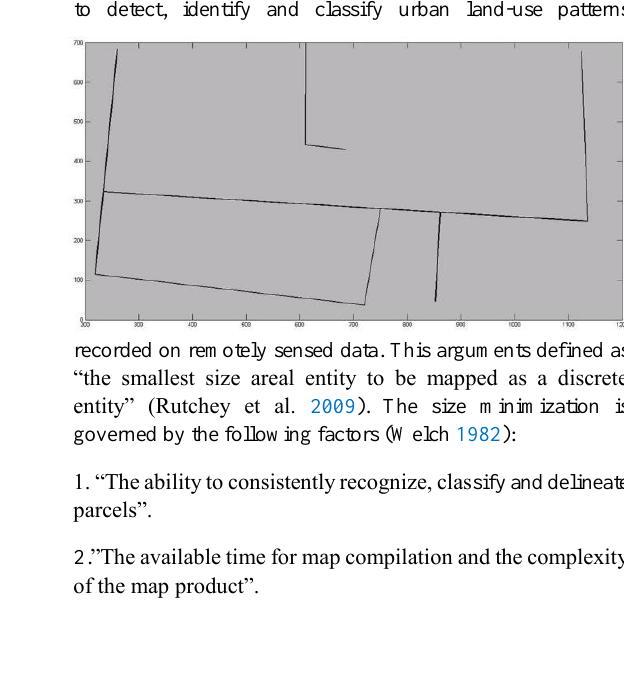
Figure 5. Final vector road centerlines extracted by RANSAC